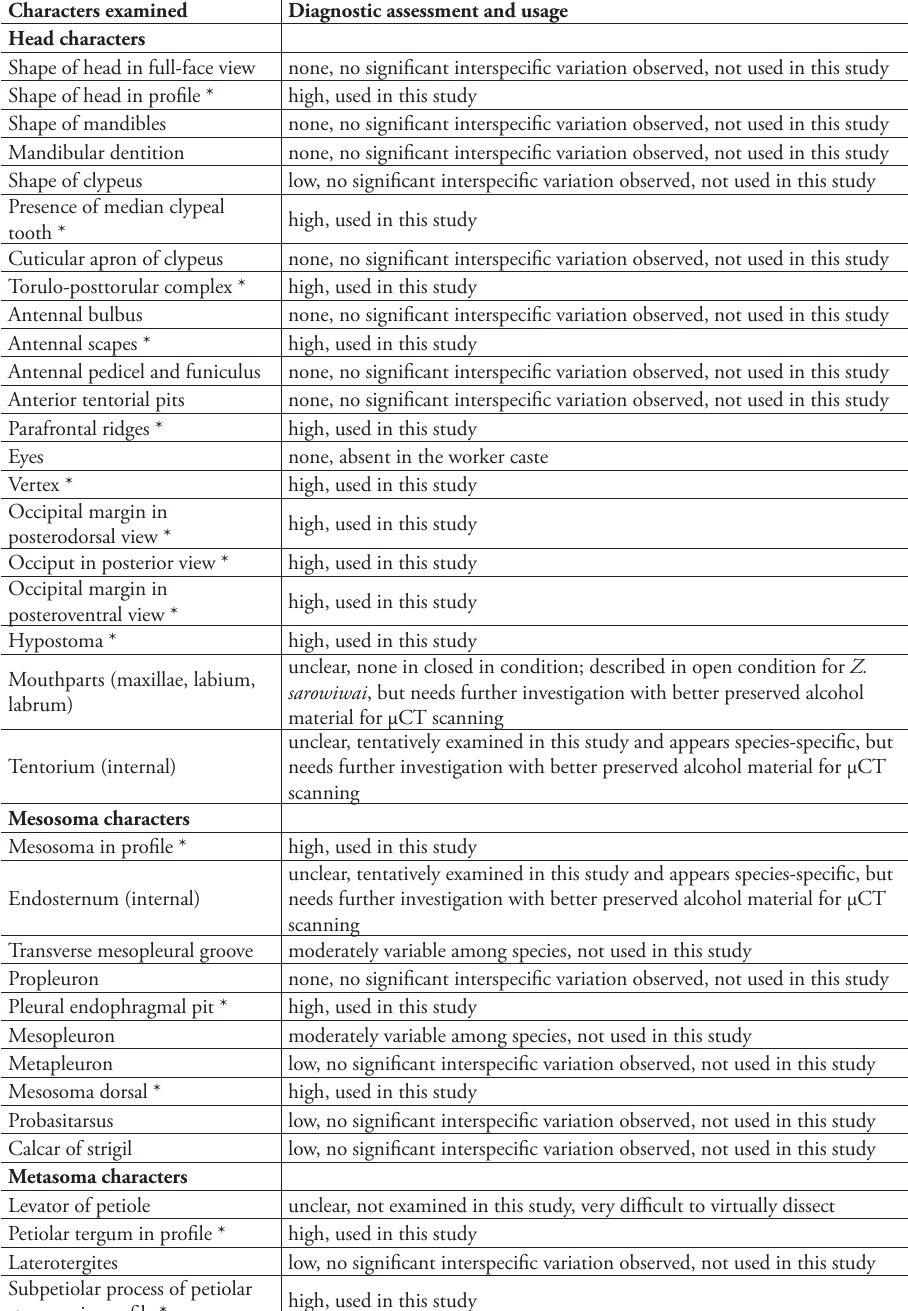
Table 2. List of all important characters examined in this study with assessment of diagnostic potential and information on usage in this study (characters marked with * were used for species